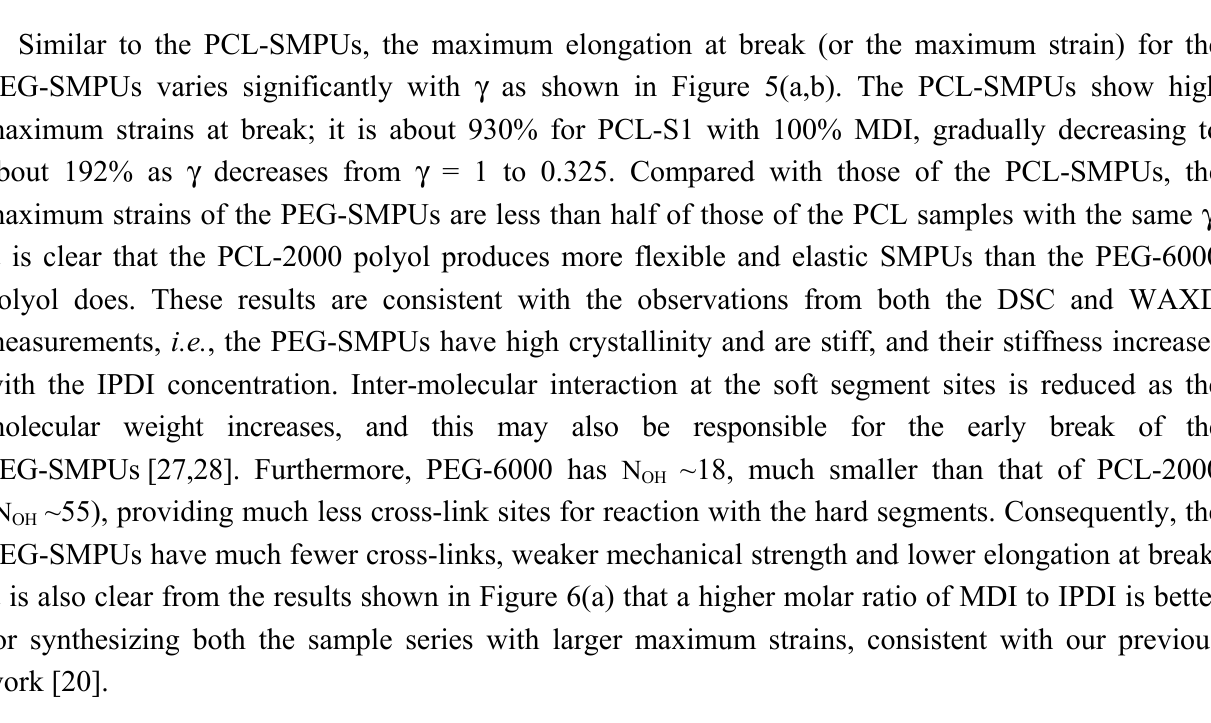
Figure 5. Stress vs . strain for PEG ( a ) and PCL-SMPUs ( b ) series at ambient temperature.